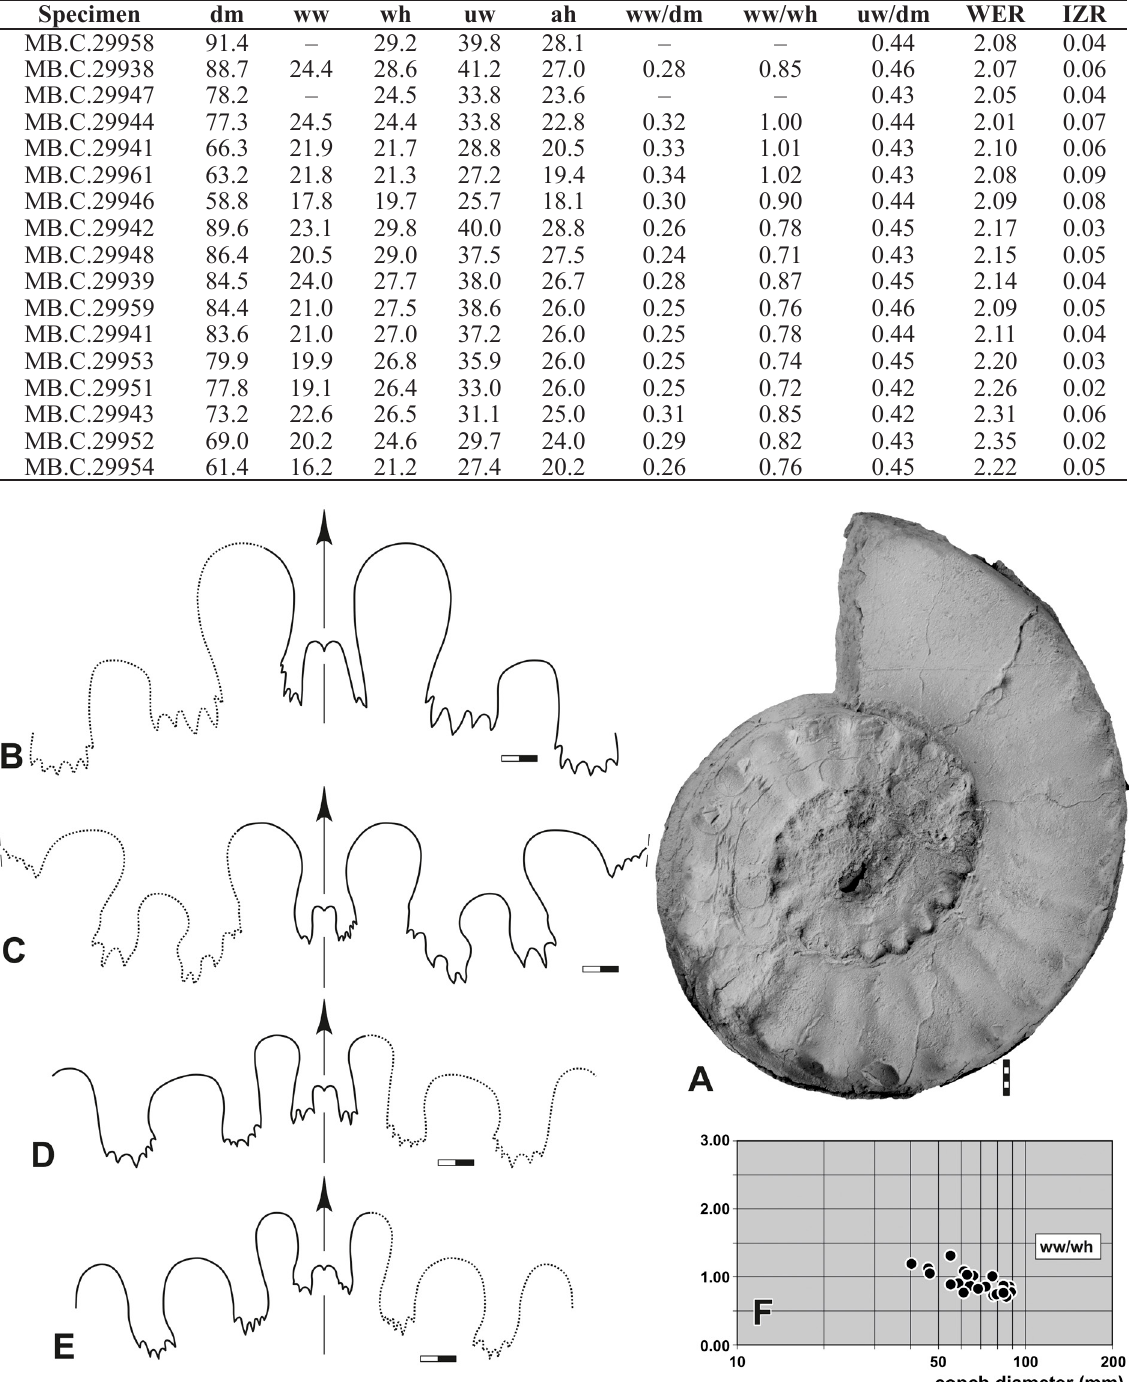
Table 20. Conch dimensions (partly estimated) and ratios of selected specimens of Clivotirolites decoratus Korn & Hairapetian gen. et sp. nov. from Baghuk Mountain.